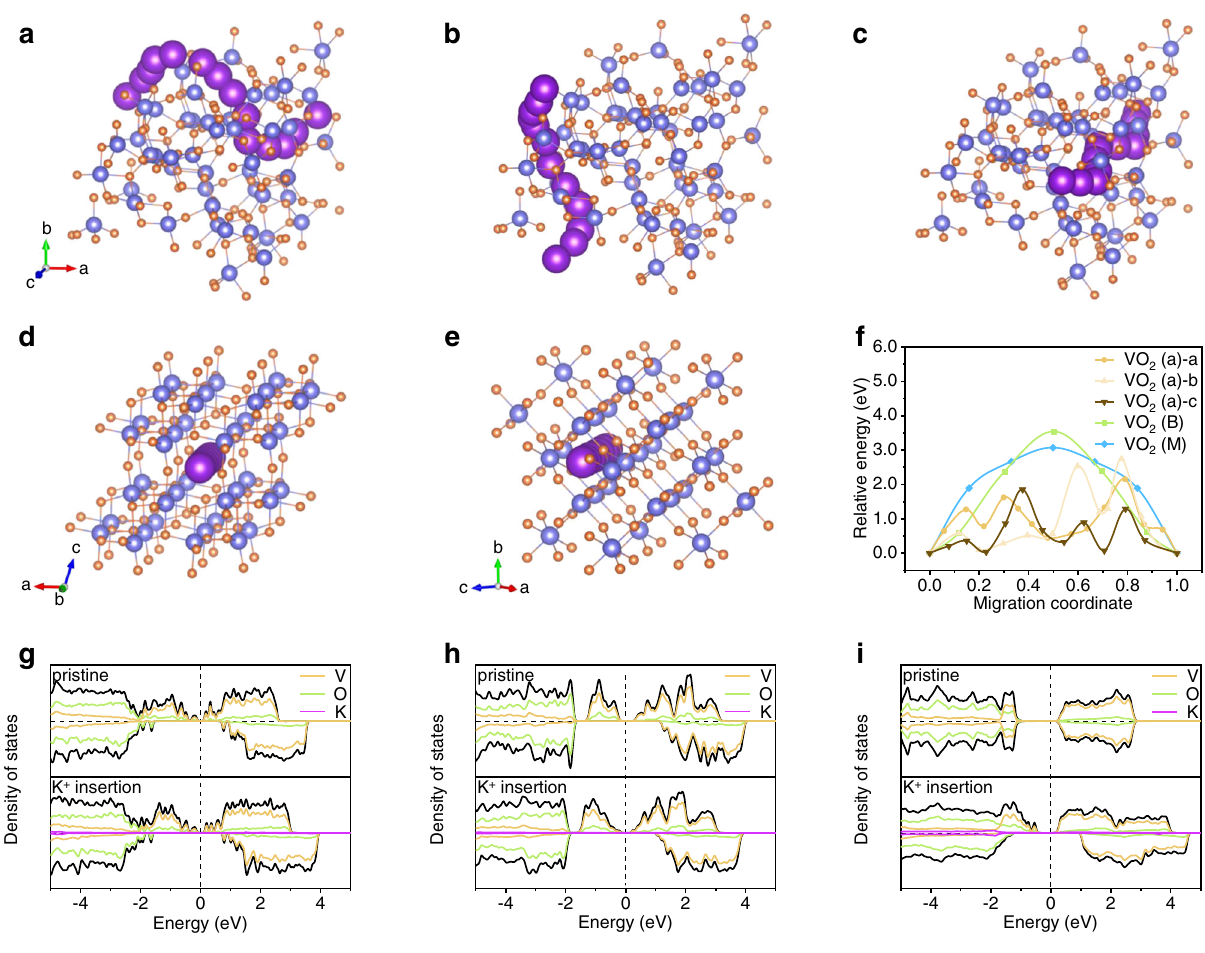
Fig. 4 | DFT calculations of K storage. The K migration paths of the a – c VO 2 (a), d VO 2 (B), e VO 2 (M). f Migration energy of K + ions for VO 2 in the three different phases. The DOS before and after K + insertion for g VO 2 (a), h VO 2 (B), i VO 2 (M).